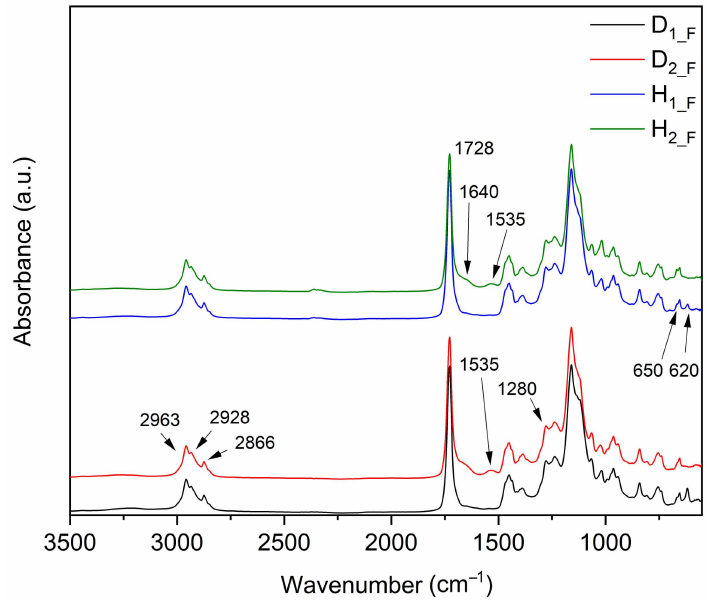
Figure 2. FT-IR absorption spectra of fluorinated copolymer samples of Series 1 and